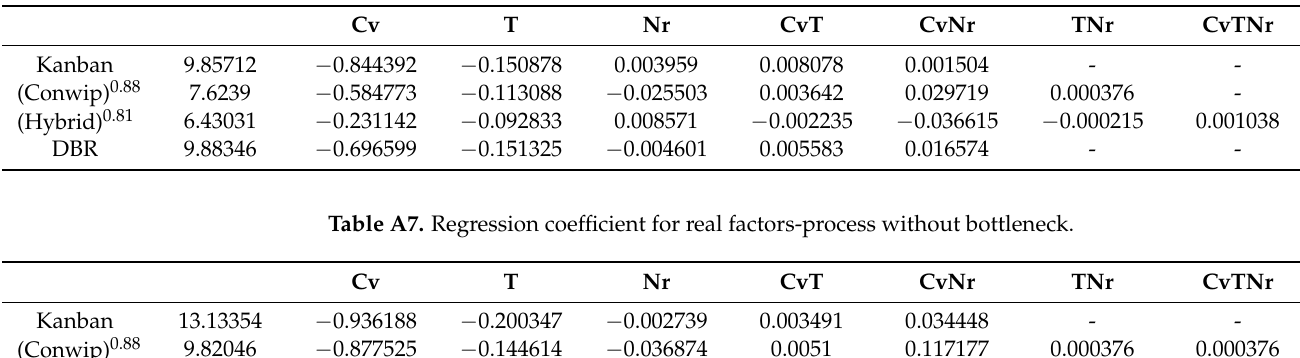
Table A6. Regression coefficient for real factors-process with bottleneck.